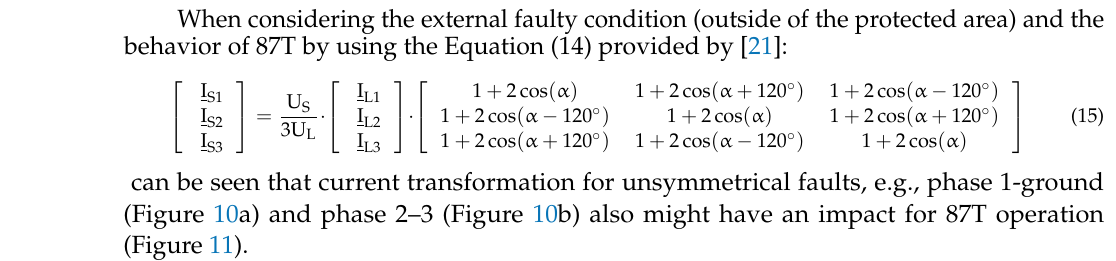
Figure 9. Influence of non-standard phase shift on ( a ) differential current, ( b ) differential & bias current amidst of the differential characteristic.